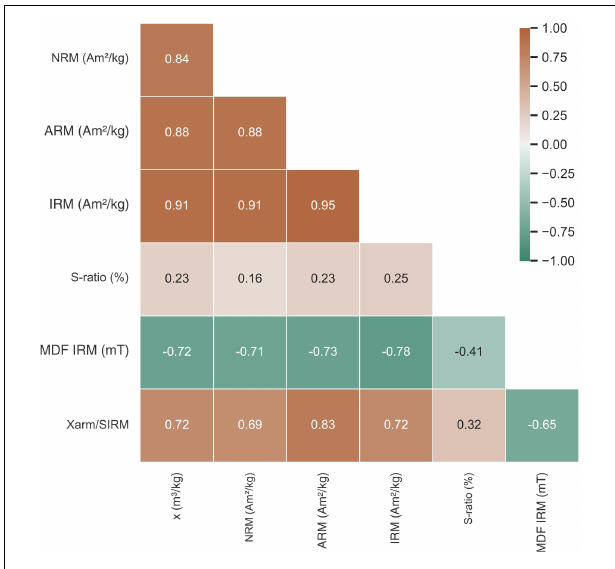
FIGURE 9 | Spearman’s rank correlation of magnetic properties of speleothems [susceptibility, natural remanent magnetization (NRM), anhysteretic remanent magnetization (ARM), isothermal remanent magnetization (IRM), S-ratio, median coercivity field of IRM, and susceptibility of ARM by IRM].